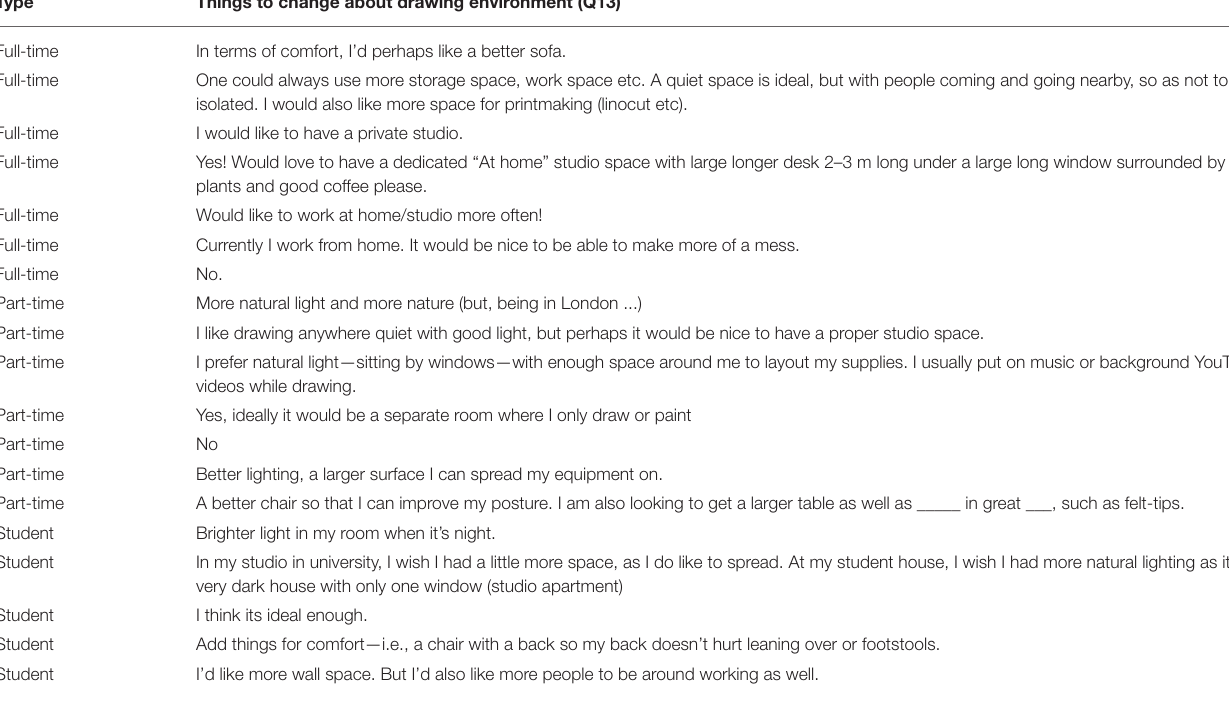
TABLE 3 | Q13 Responses to “Are there things about your drawing environment that you would want to change to make it a more ideal work setting?”. Type